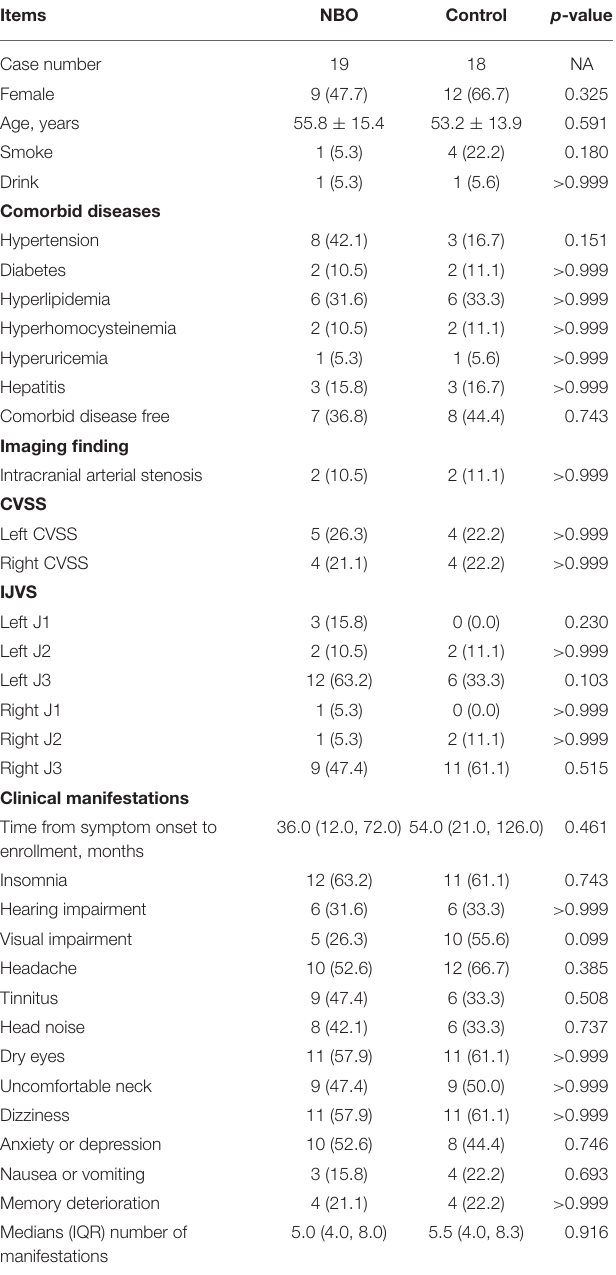
TABLE 1 | Baseline demographics of the enrolled subjects in the NBO group and the control group.